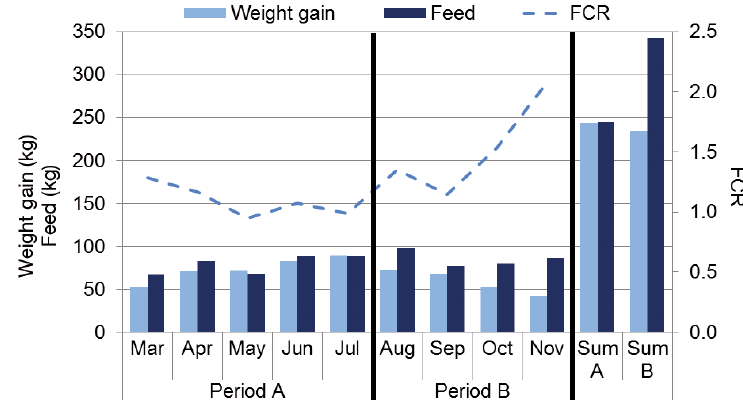
Fig. 4. Weight gain of Nile tilapia Oreochromis niloticus , amount of feed used, and feed conversion ratio (FCR: kg feed / kg gained biomass) during the course of the testing period, separated into periods between 2 sampling events. For comparability of stocking densities, the first part of Period A from March to April until completion of fish stocking (i.e. Period 1 in Fig. 3) has been omitted in Sum A so that it represents the weight gain and feed in fully stocked tanks from May to July. On 1 August, fish were stressed by oxygen depletion follow- ing a long-lasting power failure, and ~150 kg of fish died and were replaced by older individuals weighing at least 500 g, which notably affected the